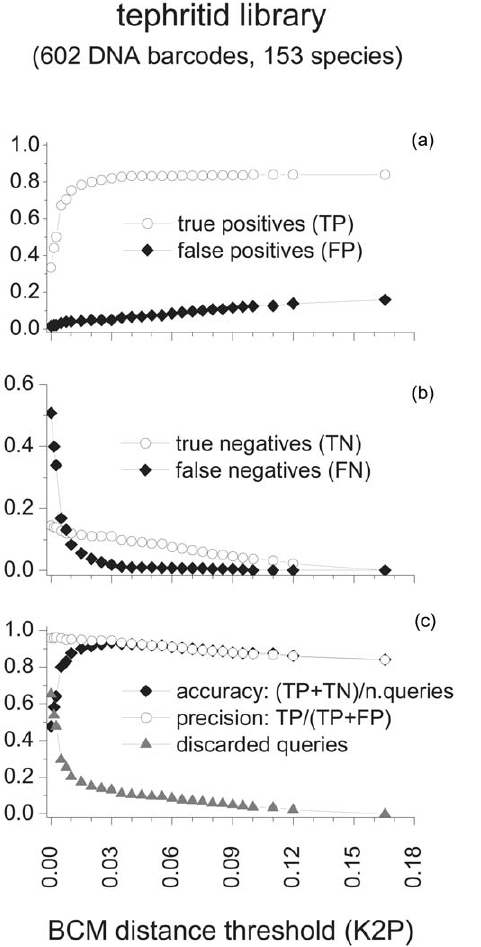
Figure 3. Relative ID errors at 30 arbitrary distance thresholds. Relative ID errors (FP/n. of not discarded queries) obtained from a library of 602 tephritid DNA barcodes. Linear fitting (95% confidence intervals are indicated) was used to infer an ad hoc distance threshold corresponding to a relative ID error , 0.05 (THR K2P_0.05 ). Error estimates were verified through the DNA barcoding identification of an indepen- dent set of 188 tephritid specimens. The grey area represents the relative ID error (estimated and observed) corresponding to THR K2P_0.05 .